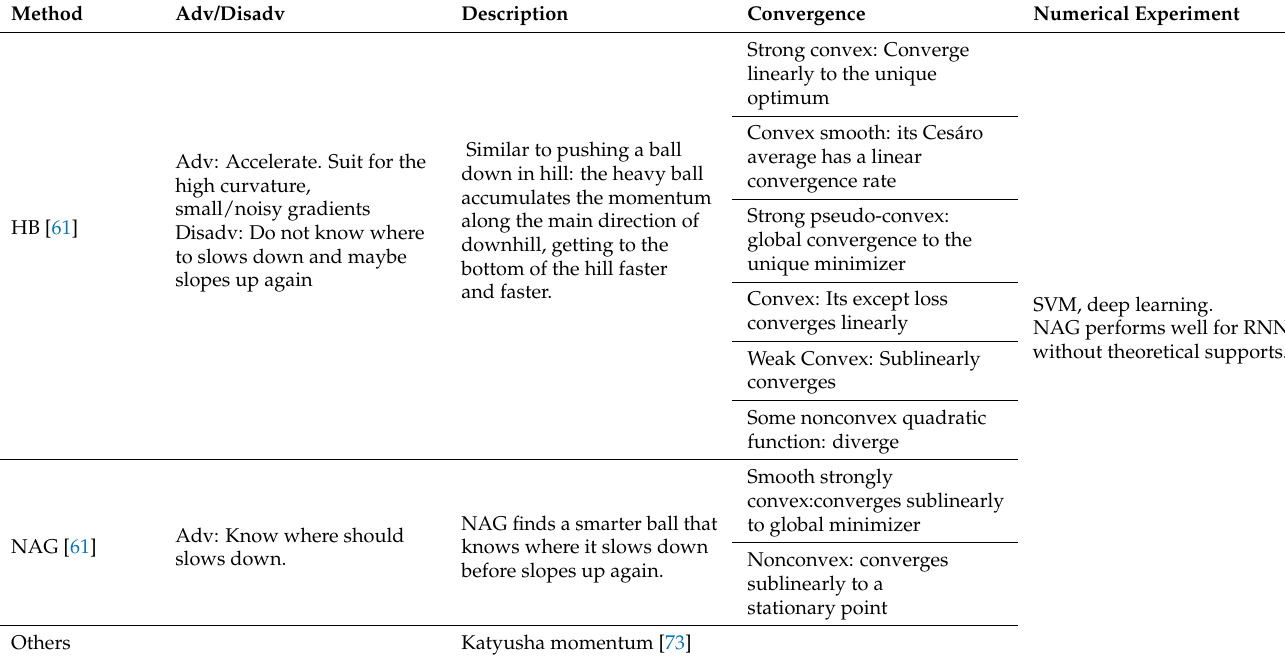
Table 4. Summary of the accelerate